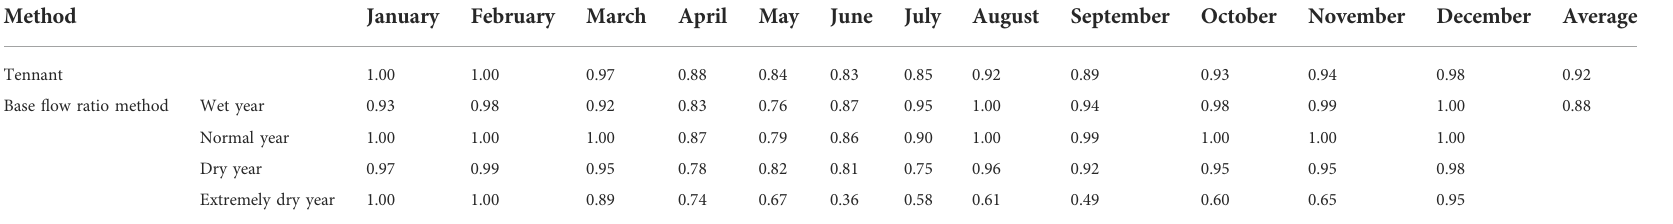
TABLE 5 Guaranteed rate of ecological base fl ow of each month by base fl ow ratio method and tennant